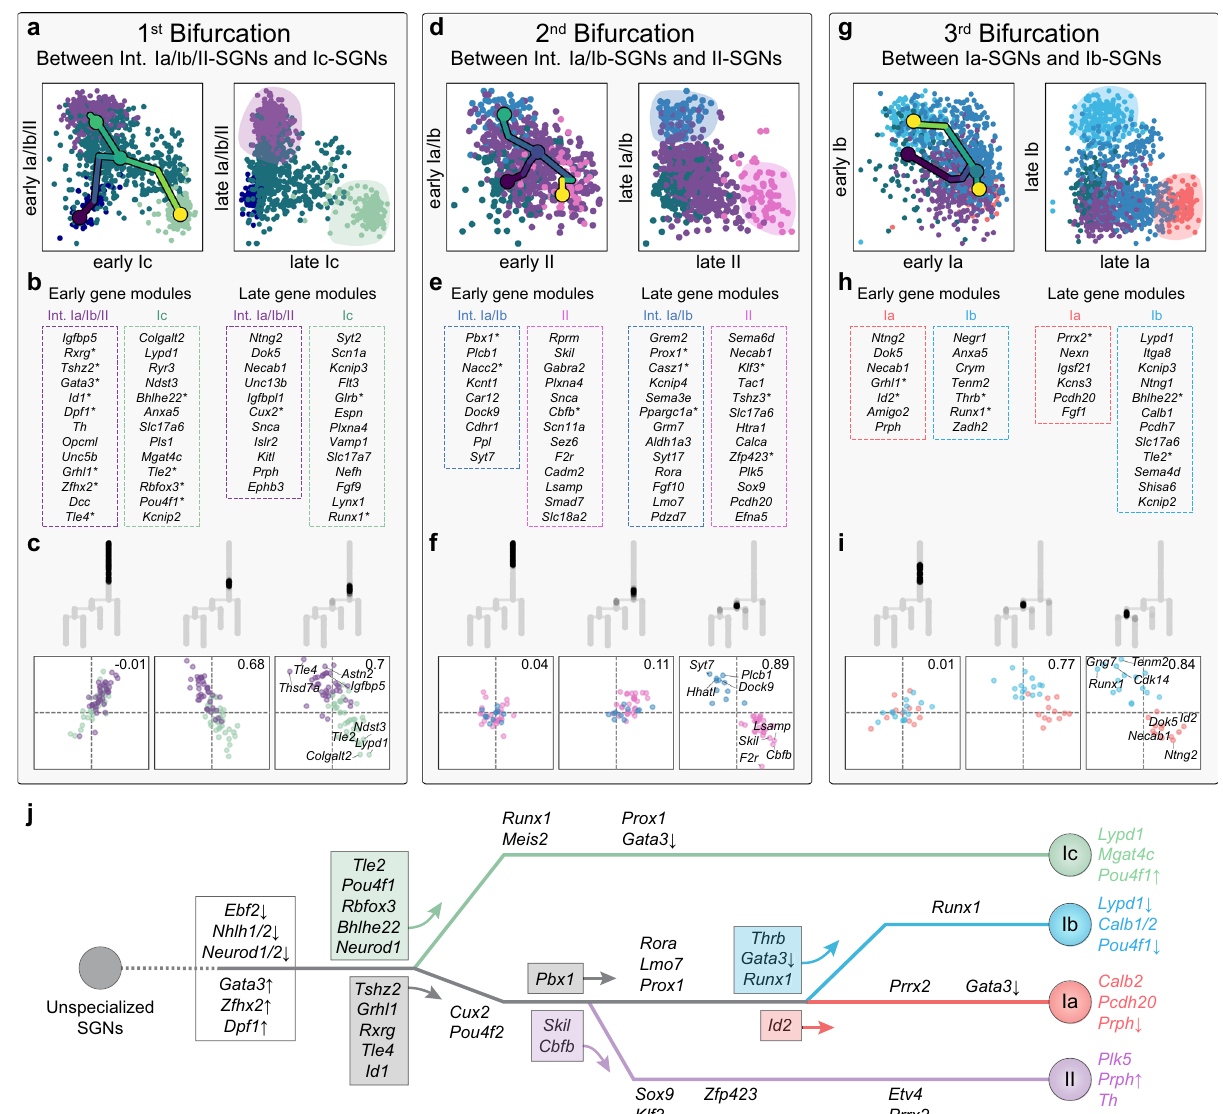
Fig. 4 Gene modules de fi ning cell fate choice and commitment along the differentiation trajectories. a – i Analysis of the bifurcations of the differentiation tree representing cell fate selection between distinct neuronal cell lineages: I c versus I a /I b /II ( a – c ), II versus I a /I b ( d – f ) and I a versus I b ( g – i ). a , d , g Scatter plots show average expression of lineage-speci fi c modules in each cell along the trajectory. Early competing modules show gradual co-activation, followed by selective upregulation of one fate-speci fi c module and downregulation of the alternative fate-speci fi c module. Late modules show almost mutually exclusive expression within the two lineages after bifurcation re fl ecting commitment to either fate. Colors encode tree branches as in Fig. 2a. b , e , h Representative genes in each module; asterisks highlight TFs (see also Supplementary Data 7). c , f , i Average local correlations of early gene modules with branch-speci fi c correlations, in cells with similar developmental pseudotime (in black on the trajectories); the difference between intra- and inter-module correlations is shown in the upper right corner of the correlation plots and would re fl ect the repulsion between modules. j Summary scheme of the cellular diversi fi cation of developing SGNs via distinct trajectories. The transcriptional regulators predicted to be involved in the unfolding of the different lineages are represented on the different trajectories and are derived from the analysis of Figs. 2 – 4. Genes in colored boxes indicate TFs of early modules from the bifurcation analysis and potentially driving speci fi c cell fate choice (arrows). The arrow symbols after the genes indicate an upregulation or downregulation within a trajectory, while they indicate a high or low expression, respectively, in the fi nal states (I a , I b , I c and II states at the far-right end of the differentiation tree). Int.,